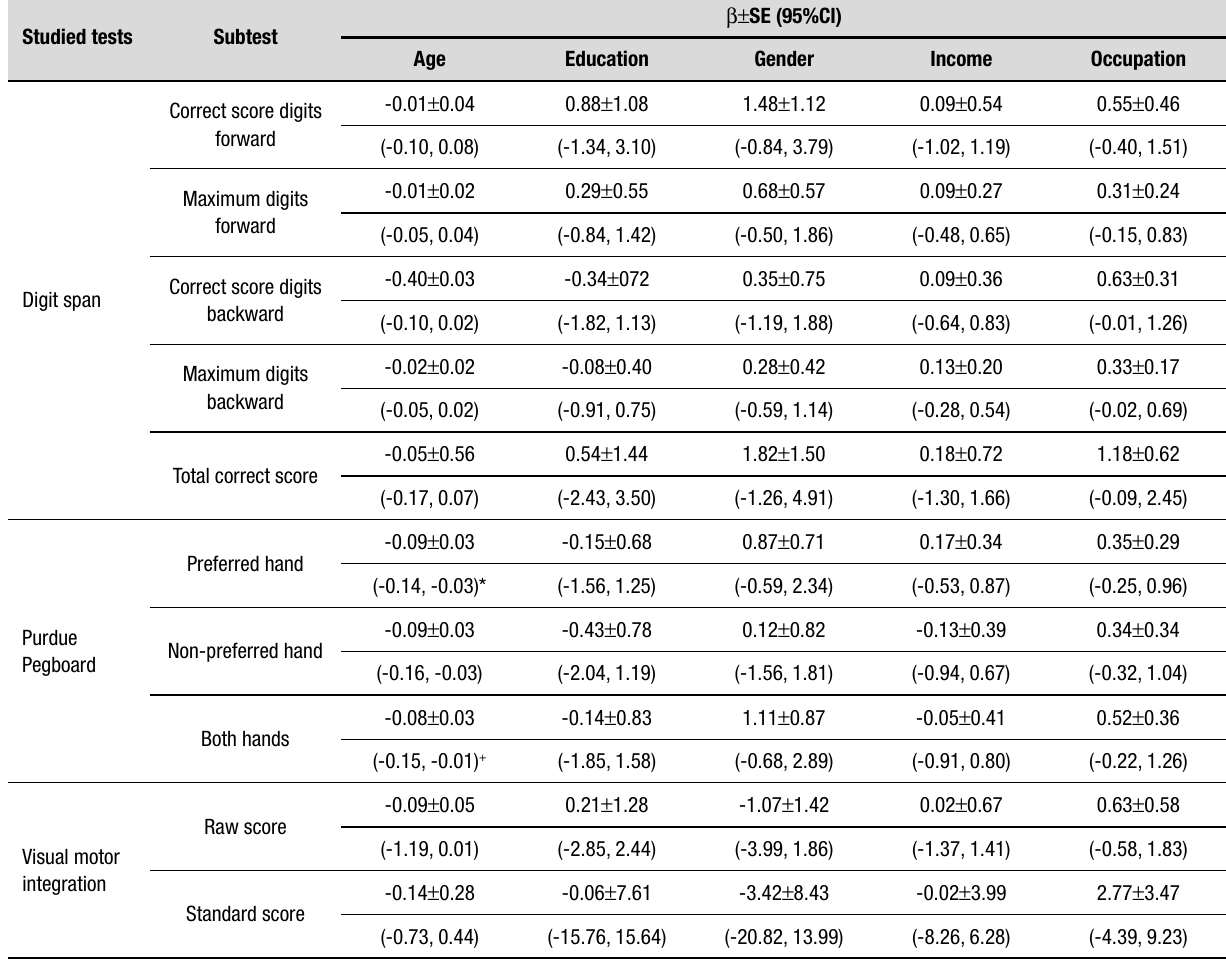
Table 3. Effect of demographic data on digit span, Purdue Pegboard, and visual motor integration tests